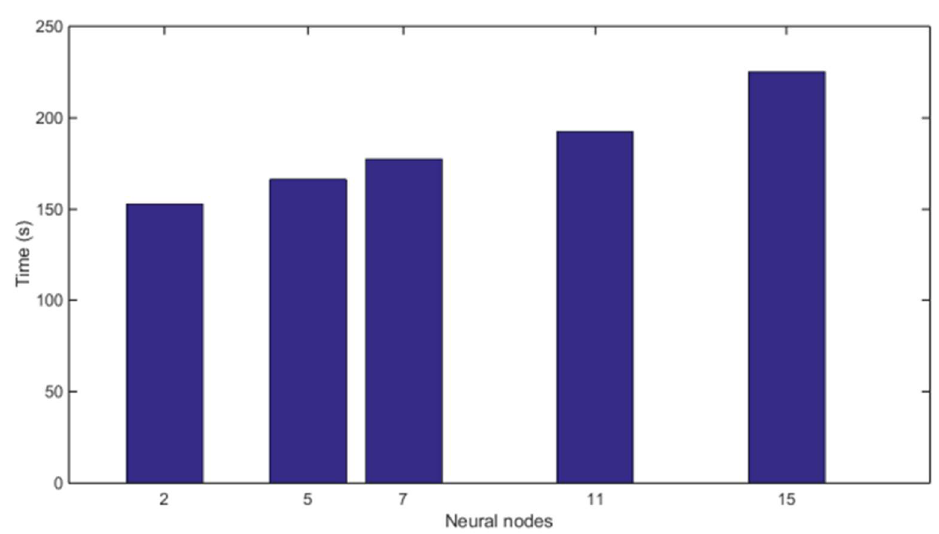
Figure 16. Time consuming of solving non-linear observers with different numbers of neural nodes.